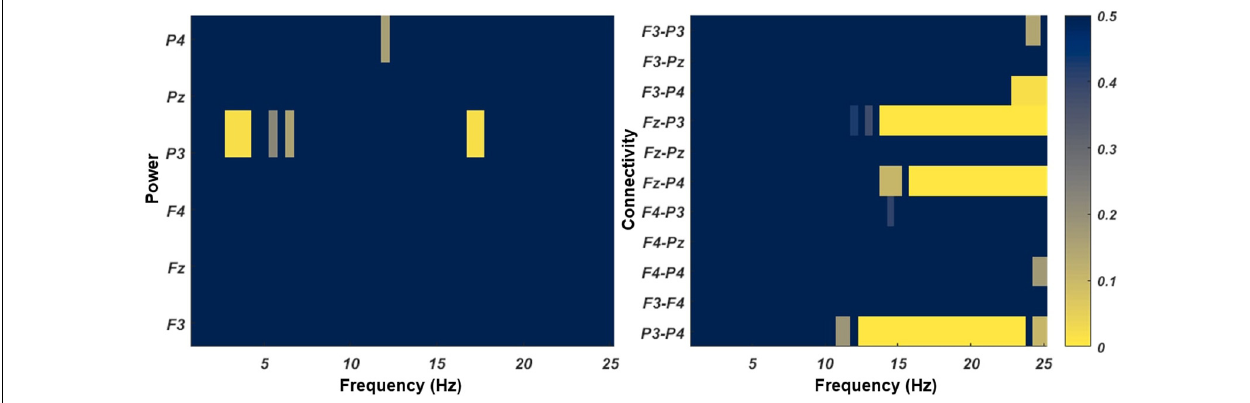
did not interact with the training protocols (vsWM + NL